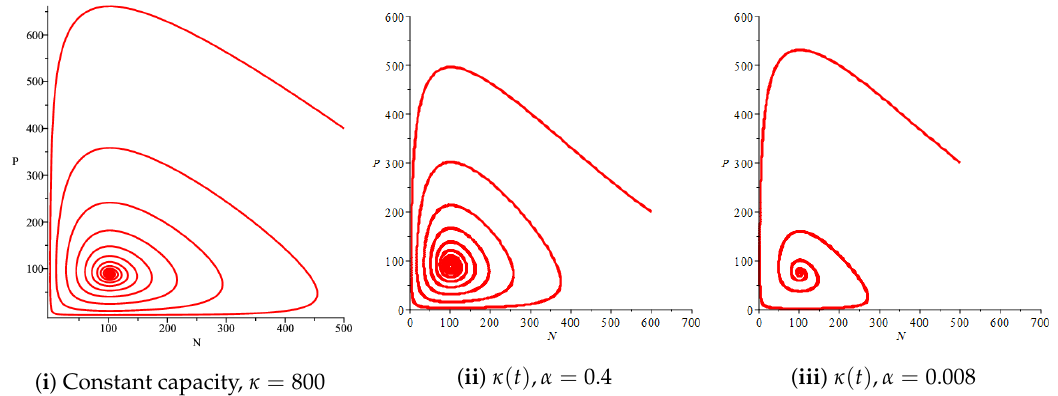
Figure 9. Effect of the logistic variable carrying capacity on the phase space of the prey and predator model with Holling type II functional response for κ 1 = 300, κ 2 = 500, r = c = 0.25, a = b = 0.0025, γ = 0.0002.